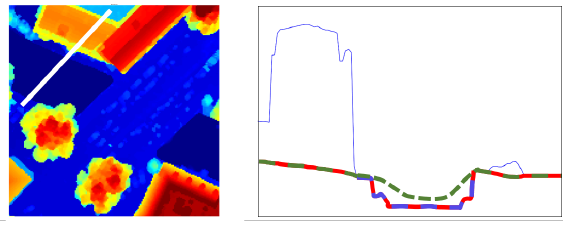
with a white profile line. On the right, elevation profiles: DSM (dashed-blue), DTM 1 , 2 temp (dashed-green), and DSM lying below DTM 1 , 2 temp (dashed-red).